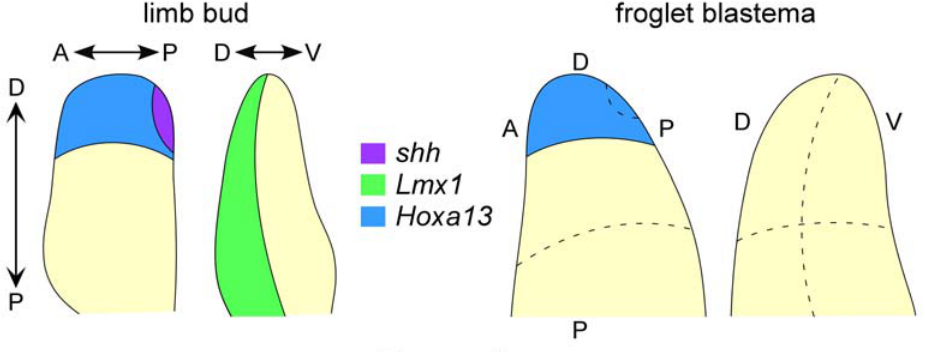
FIGURE 4. Schematic representations showing expression pattern of regulatory genes important for pattern formation along three axis (A–P, anterior-posterior; D–V, dorsal-ventral; P–D, proximal-distal) in the tadpole limb bud and froglet blastema. Shh (purple) is expressed in the posterior margin of the limb bud mesenchyme (ZPA). Lmx1 (green) is expressed in the dorsal mesenchyme of the limb bud. However, neither of these genes is expressed in the froglet blastema. On the other hand, Hoxa13 (blue) is expressed in the distal region of both the limb bud and froglet